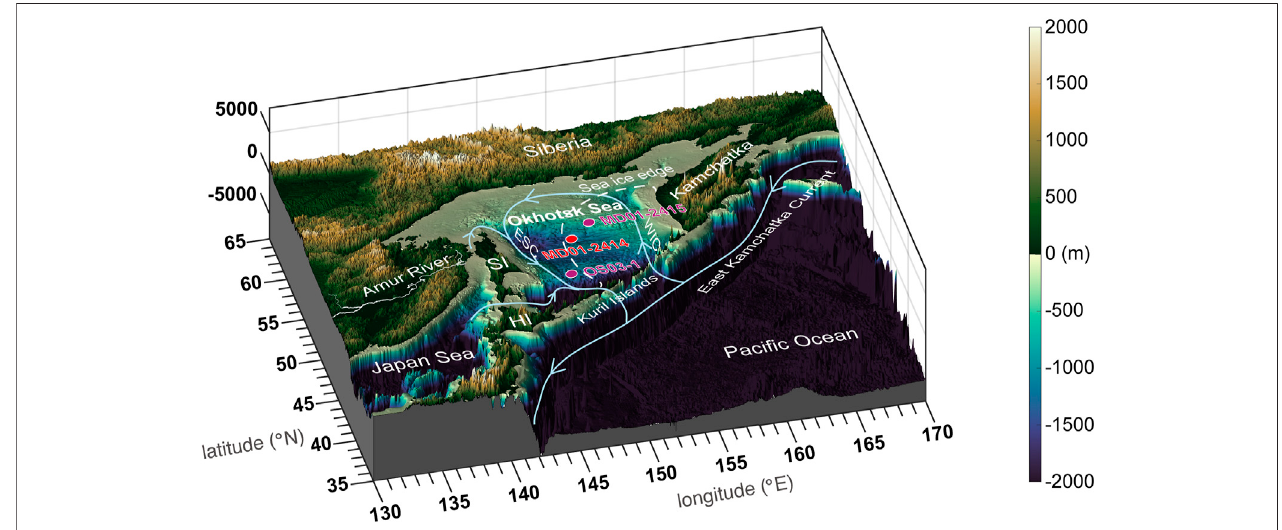
FIGURE 1 | Topography map of Okhotsk Sea showing the locations of study core MD01-2414 (red cycle) and reference cores (MD01-2415 from Nürnberg and Tiedemann, 2004; OS03-1 from Zou et al., 2015). Arrows indicate the ocean surface currents in sea (WKC: West Kamchatka Current; ESC: East Sakhalin Current). The present edge of sea-ice limits from March to April is shown by a white dash line (After Shiga and Koizumi, 1999). SI, Sakhalin Island; HI, Hokkaido Island.